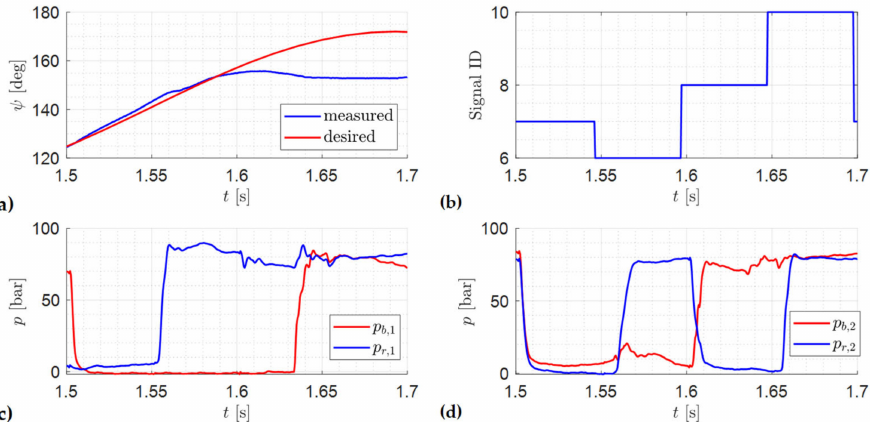
Figure 30. ( a ) Zoomed view of plot from Figure 29d; ( b ) valve configurations commanded by the controller; ( c ) pressure in cylinder 1 chambers; ( d ) pressure in cylinder 2